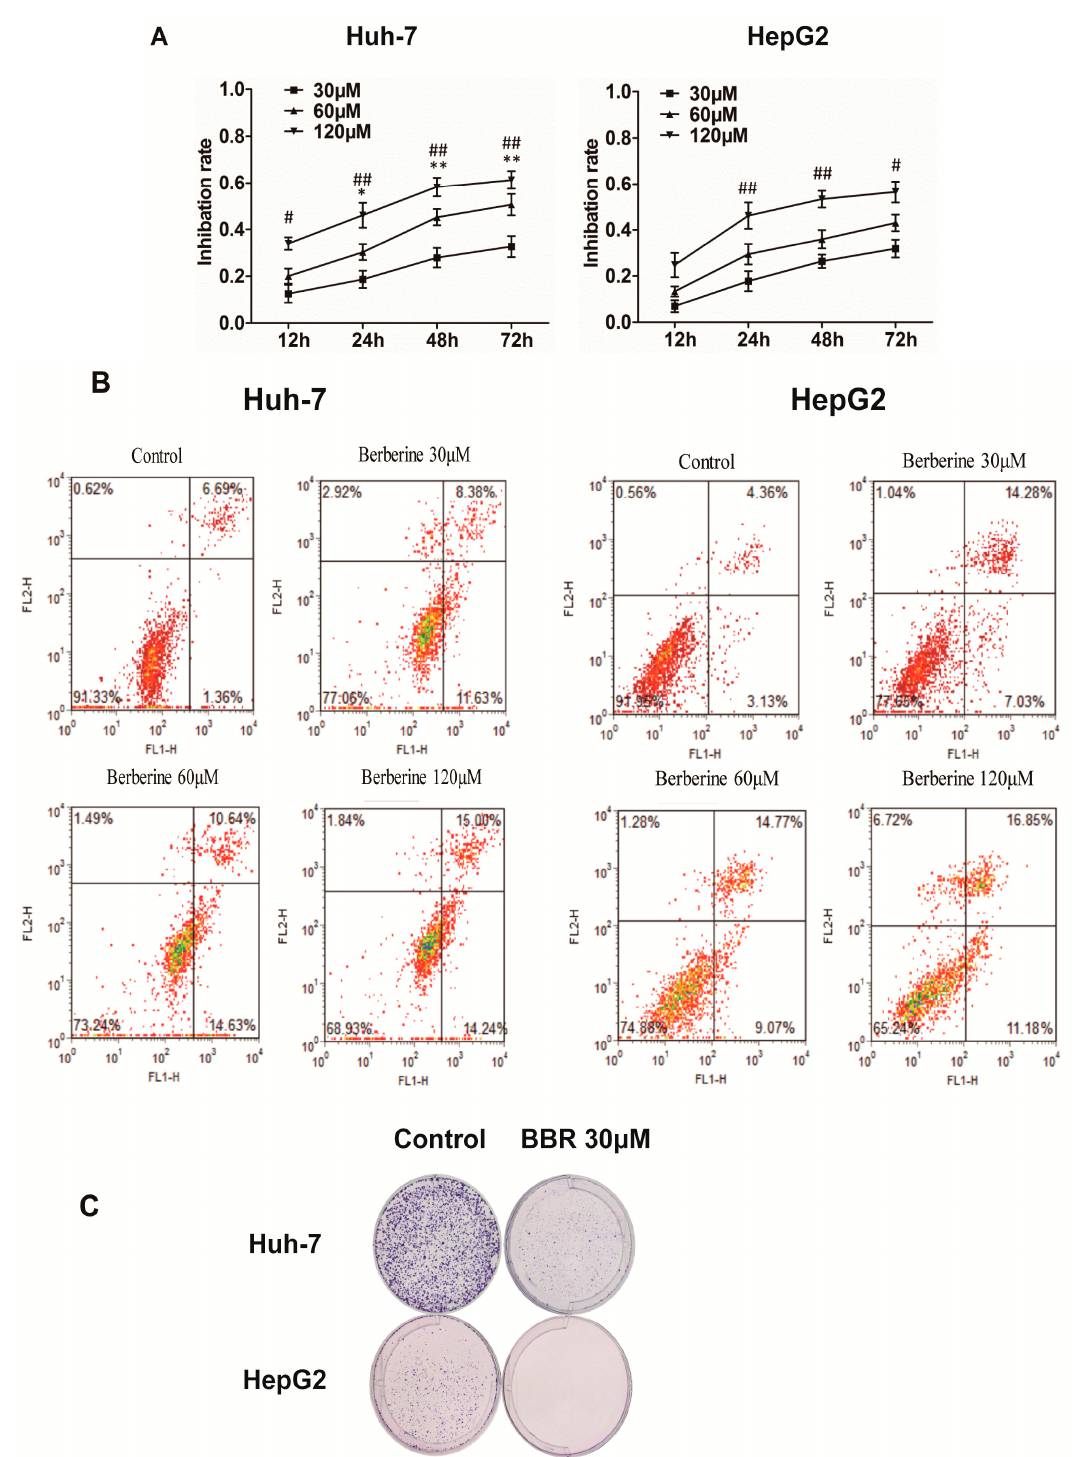
Figure 1. Berberine treatment inhibits the viability and clonogenicity of Huh-7 and HepG2 cells. ( A ) Inhibition rate of indicated cells after berberine (30–120 μ M) treatment for 12–72 h was detected by CCK8 assay. In the line graphs, * represents p < 0.05, and ** represents p < 0.01 (60 vs. 30 μ M); # represents p < 0.05, and ## represents p < 0.01 (120 vs. 30 μ M). The experiments were carried out for three times; ( B ) Flow cytometry analysis of apoptosis cells assessed using annexin V/PI dual staining after 24 h treatment of Huh-7 and HepG2 cells with 30, 60, and 120 μ M berberine; ( C ) Clonogenic analysis of Huh-7 and HepG2 cells after berberine treatment. The indicated cells were cultured with DMSO (control) or 30 μ M berberine for 14 days. Colonies were fixed and stained with Giemsa solution. PI: propidium iodide; BBR: berberine.